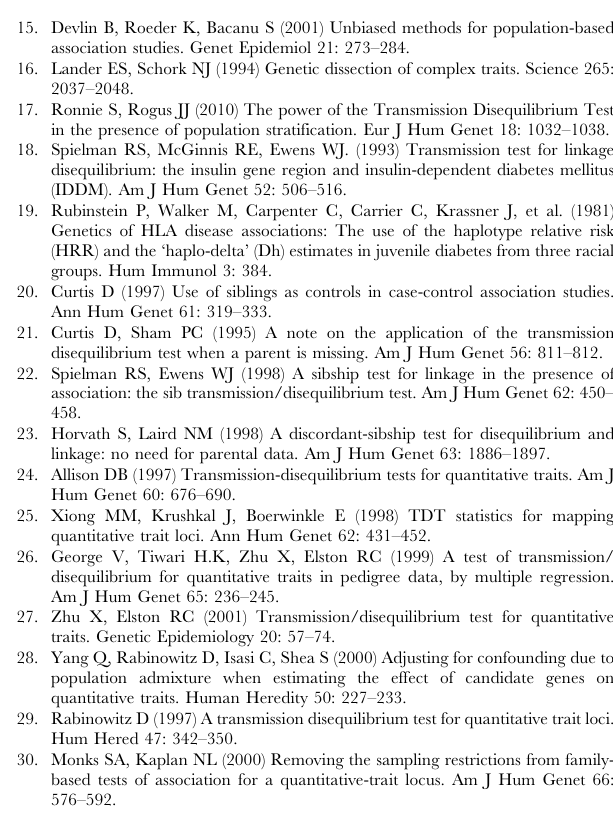
Table S1 Dominant (K = 0.01). Table S2 Dominant (K = 0.1). Table S3 Dominant (K = 0.2). Table S4 Recessive (K = 0.01). Table S5 Recessive (K = 0.1).